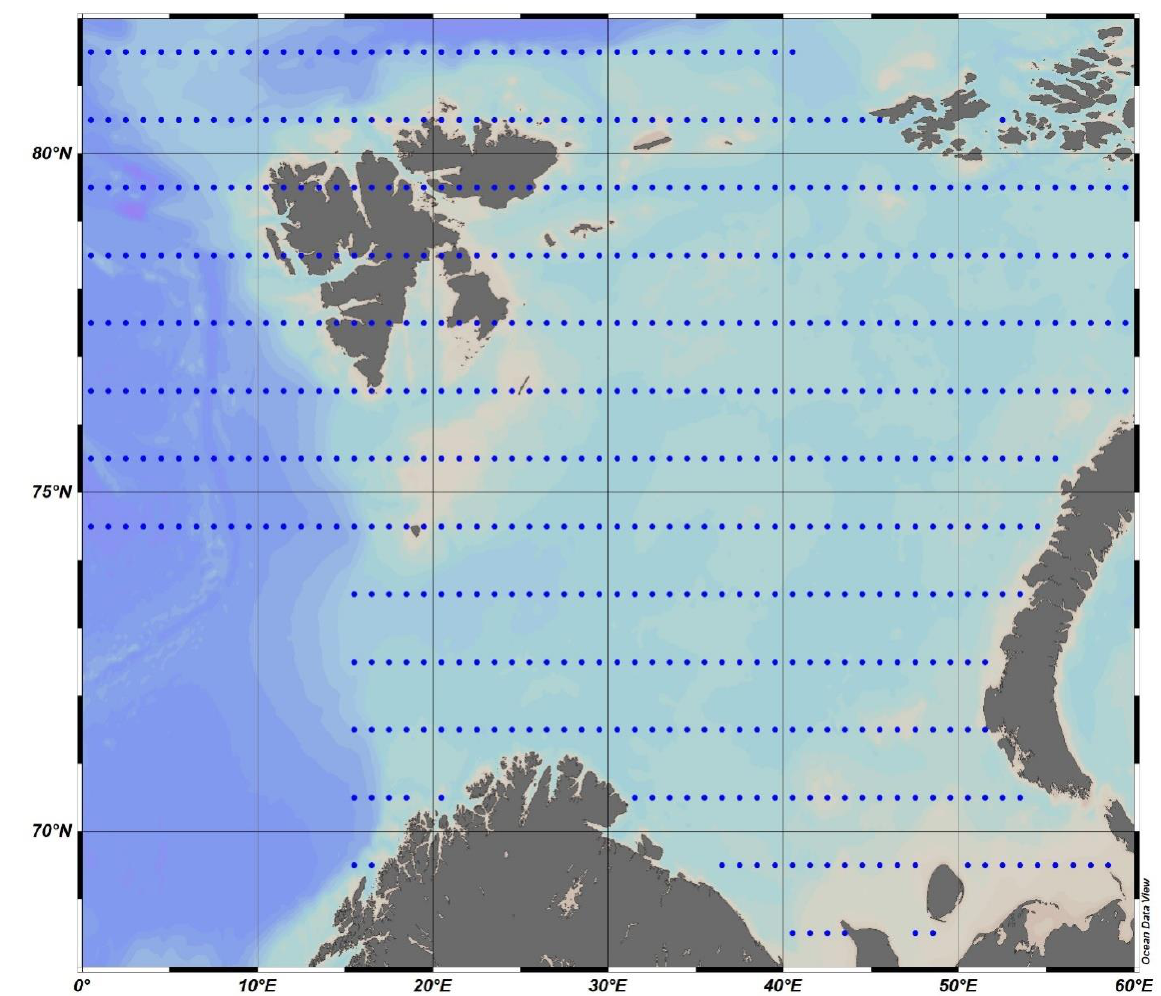
Figure 1. Position of grid nodes (blue points) in the oceanographic atlas WOA18 [22].